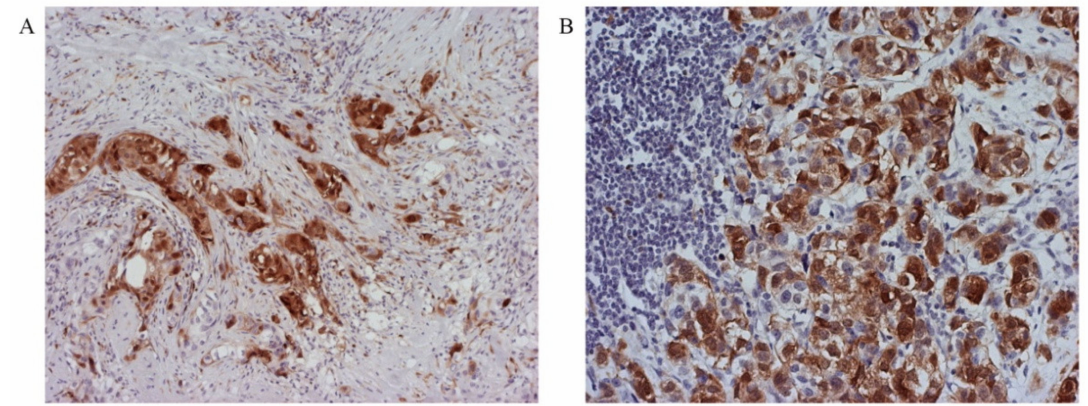
Figure 4. ( A ) p16 overexpression in stromal fibroblasts (original magnification 400 × ) and ( B ) rich mononuclear infiltrate in p16 positive IBCs (original magnification 400 ×